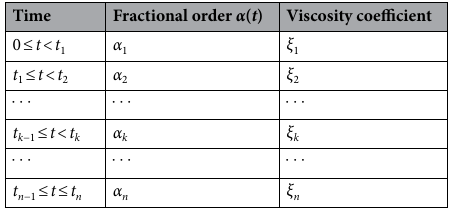
Table 1. Values of fractional order and viscosity coefficient versus